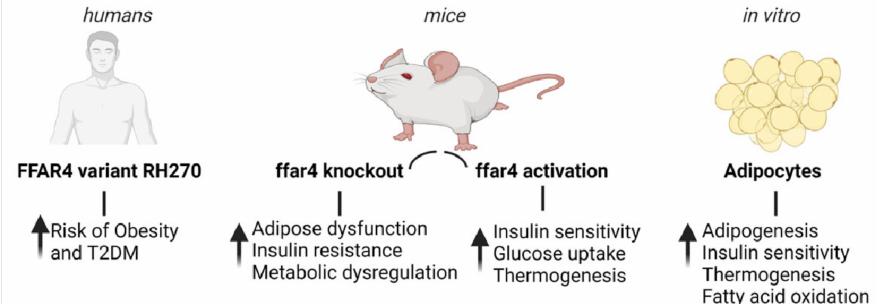
Figure 2. Physiological significance of FFAR4 in adipose tissue metabolism. Evidence from human, mouse, and in vitro